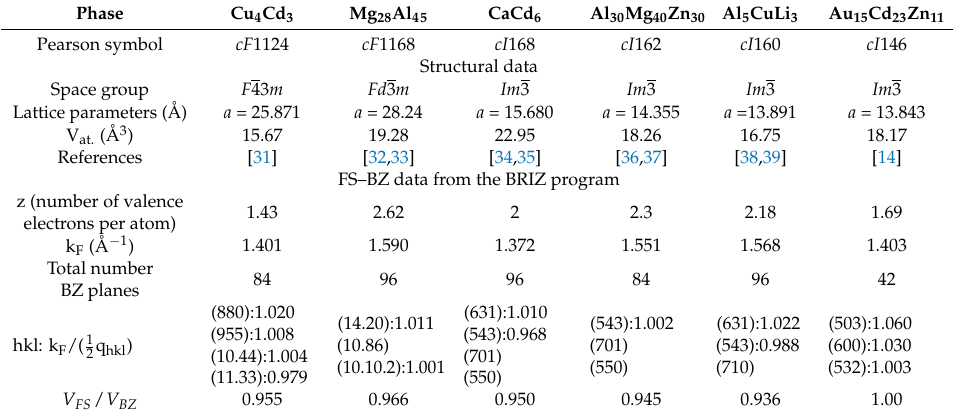
Table 1. Structure parameters of several metallic compounds with giant unit cells and quasicrystal approximants. Fermi sphere radius k F , ratios of k F to the distances of the Brillouin zone planes 1 and the filling degree of the Brillouin zones by electron states V FS /V BZ are calculated by the program BRIZ